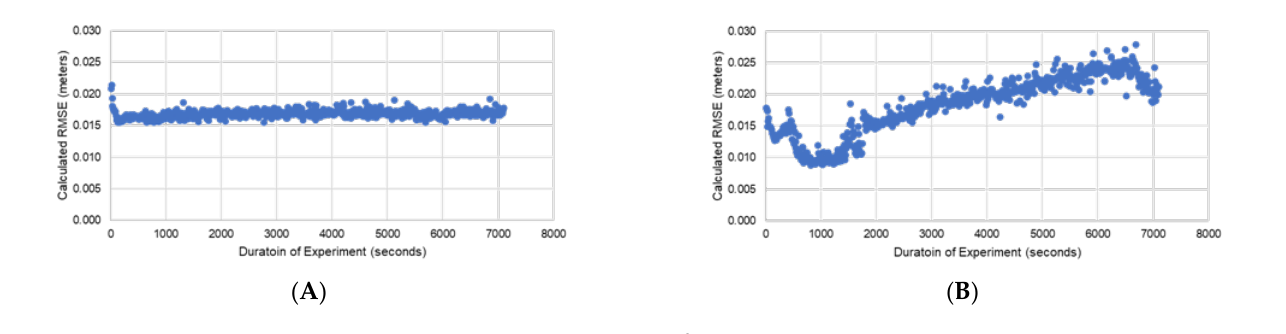
Figure 22. RMSE (m) per Velodyne ® HDL–32E observation file for both ( A ) night and ( B ) day iterations of absolute accuracy experiments.